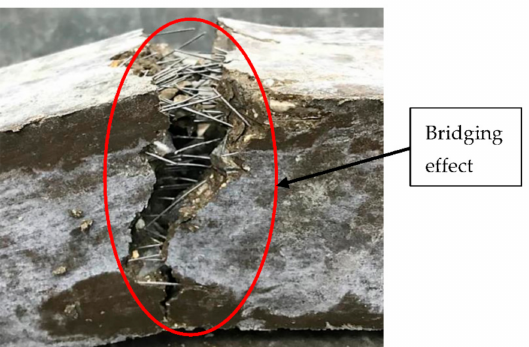
Figure 8. Sample of Steel Fiber Reinforcement Geopolymer Concrete (SFRGC) after a flexural test shows the bridging effect at the cracking